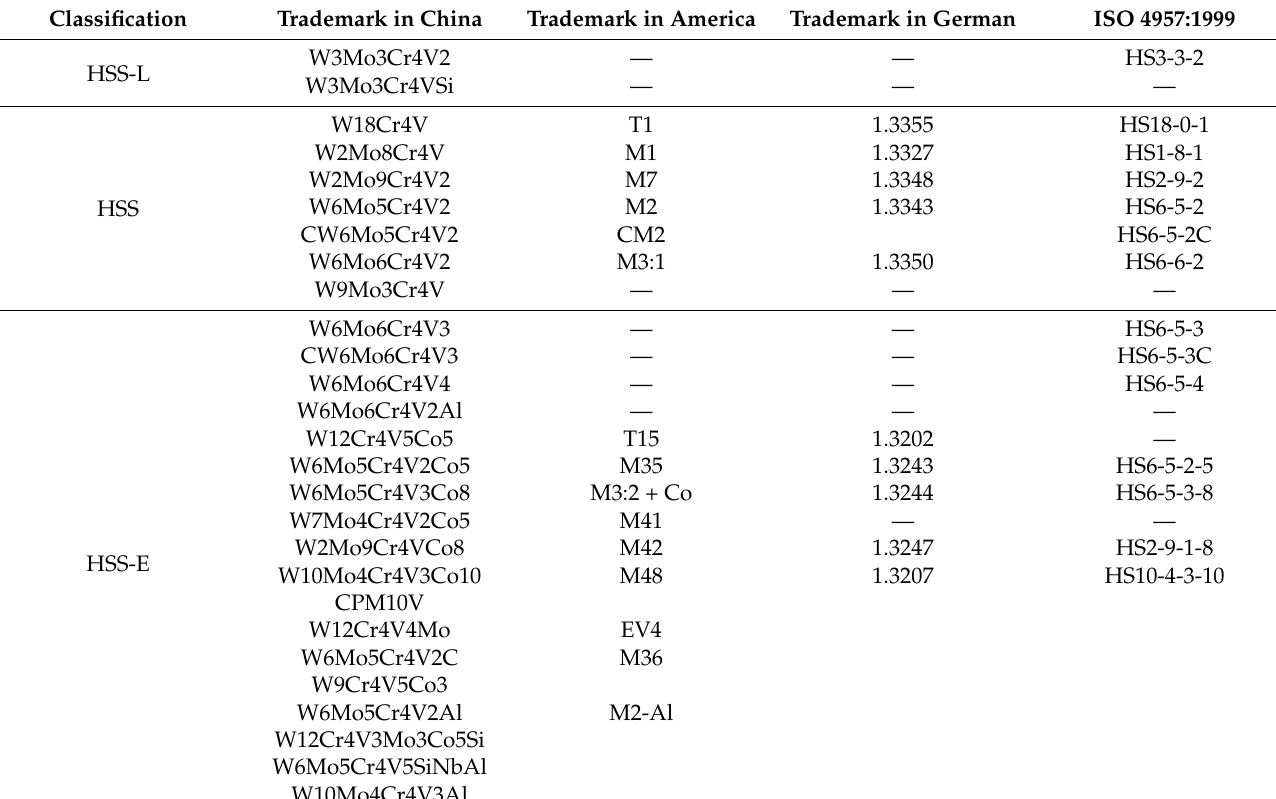
Table 1. The classification and trademarks of HSS